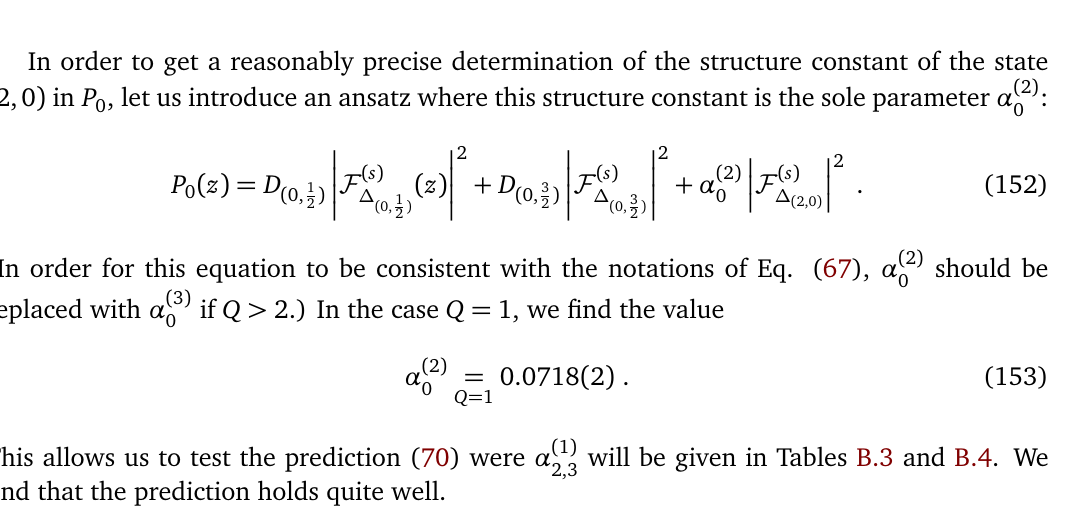
( z ) as a function of the cross-ratio z for Q = 1,2,3: comparing Monte- Figure B.2: P 0 Carlo data (crosses) with the first term truncation (thin red line) and the best fit of the form (148) (blue